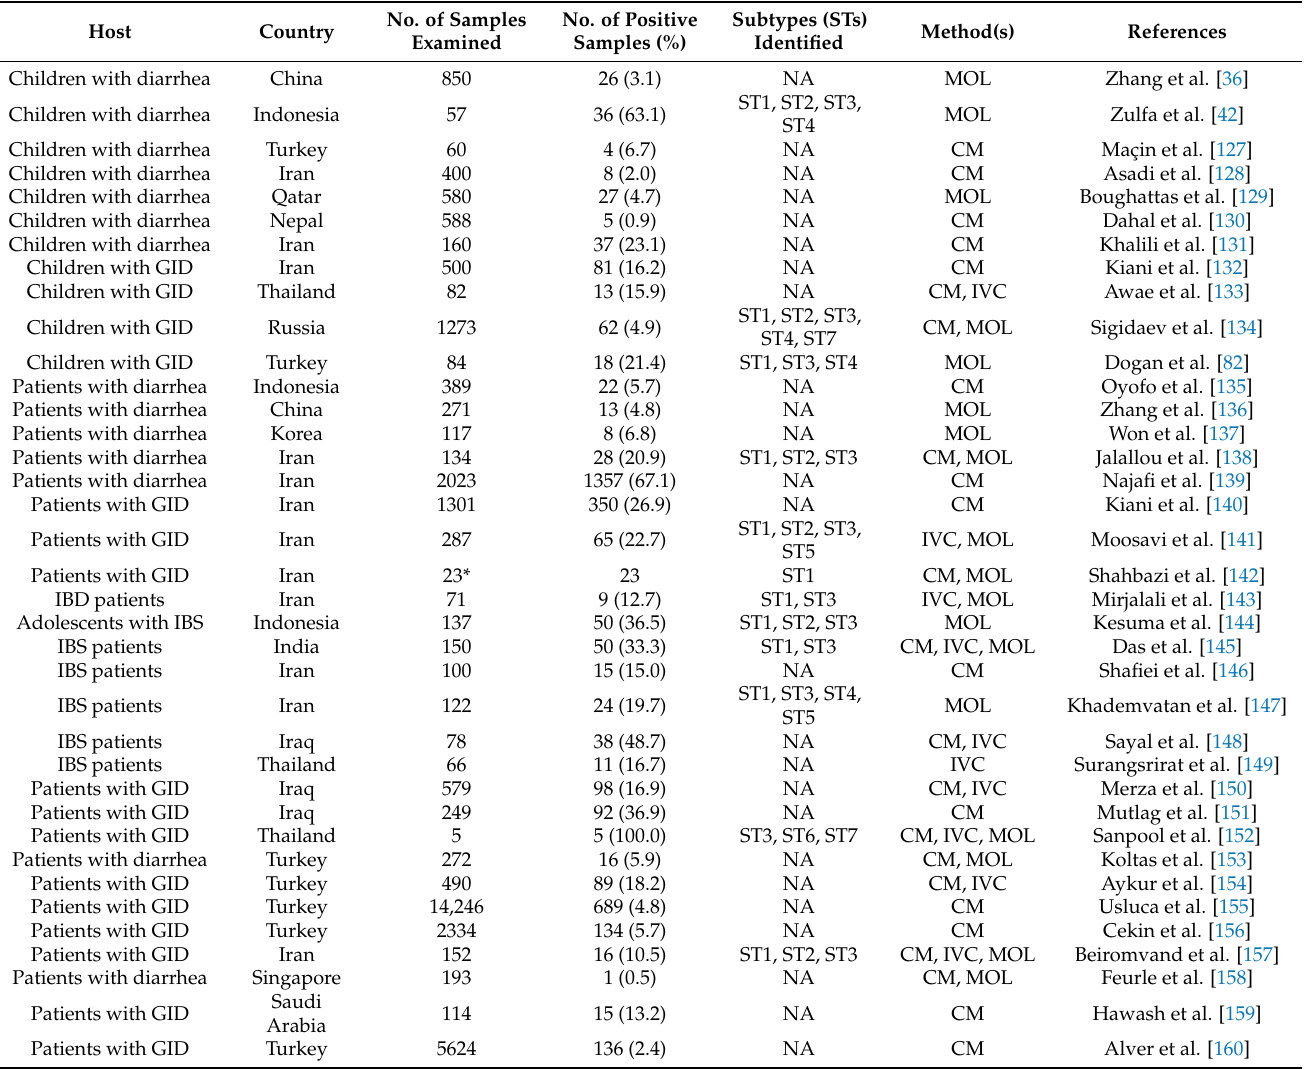
Table 3. Prevalence and subtype distribution of Blastocystis spp. in humans with gastrointestinal symptoms in Asia